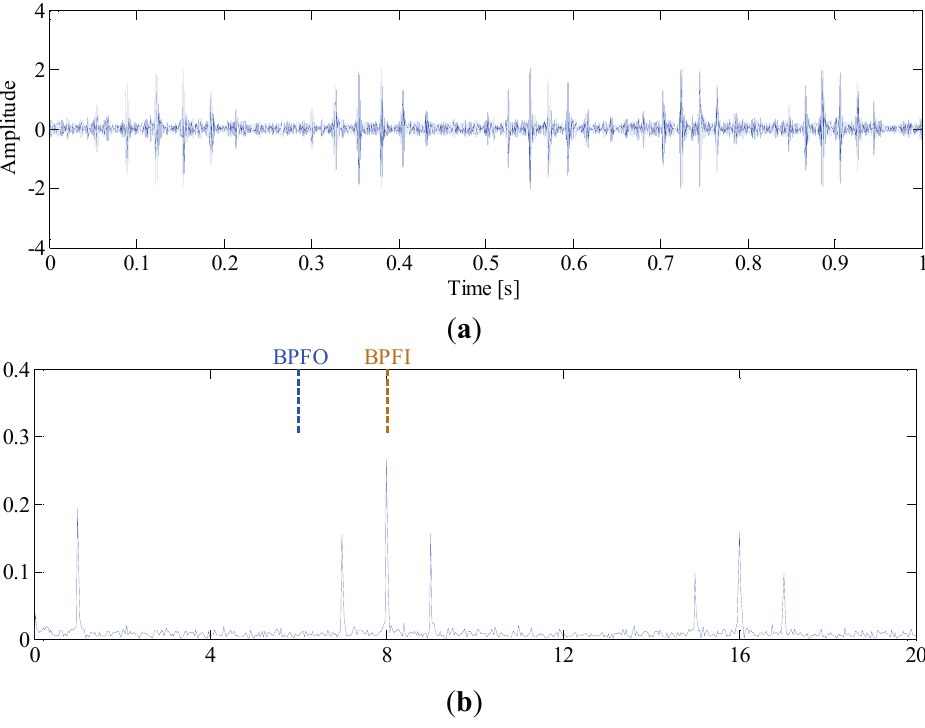
Figure12. ( a ) Waveform and ( b ) envelope order spectrum of band-pass filtered